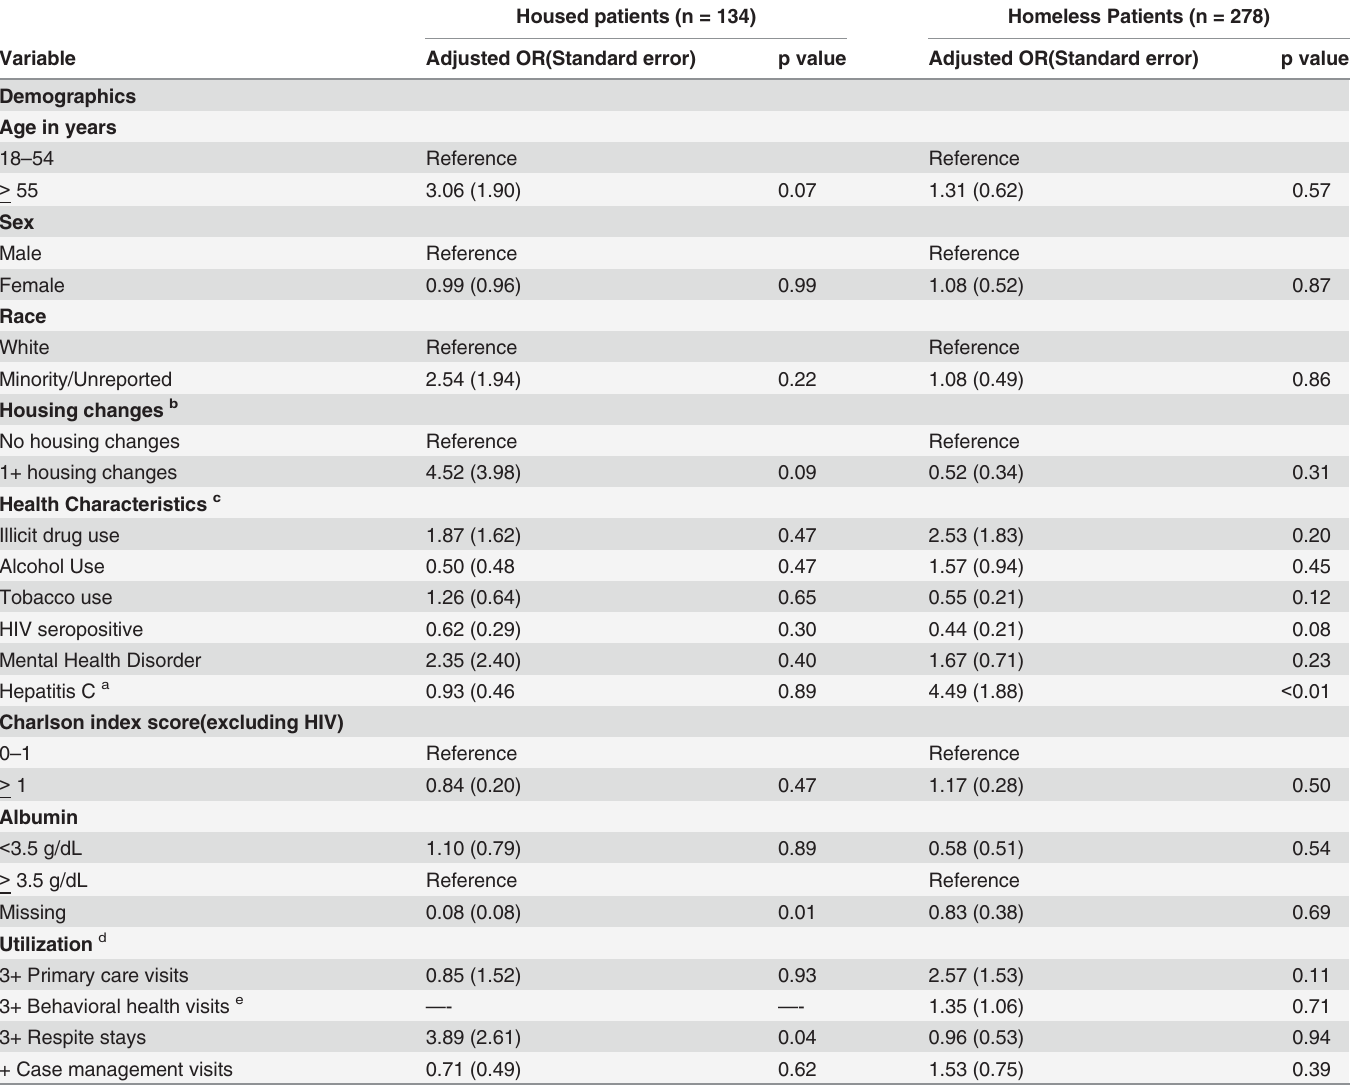
Table 2. Multivariable Analysis: Predictors of Frequent Emergency Room Visits by Housing Status, Using Clustered Data. Housed patients (n =